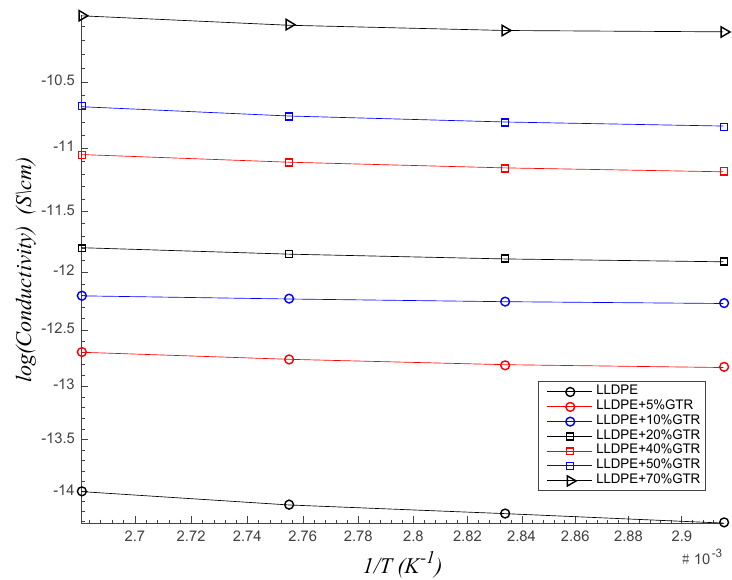
Figure 10. Linear fitting of log ( σ dc ) versus 1 / T for composites with di ff erent amounts of GTR.